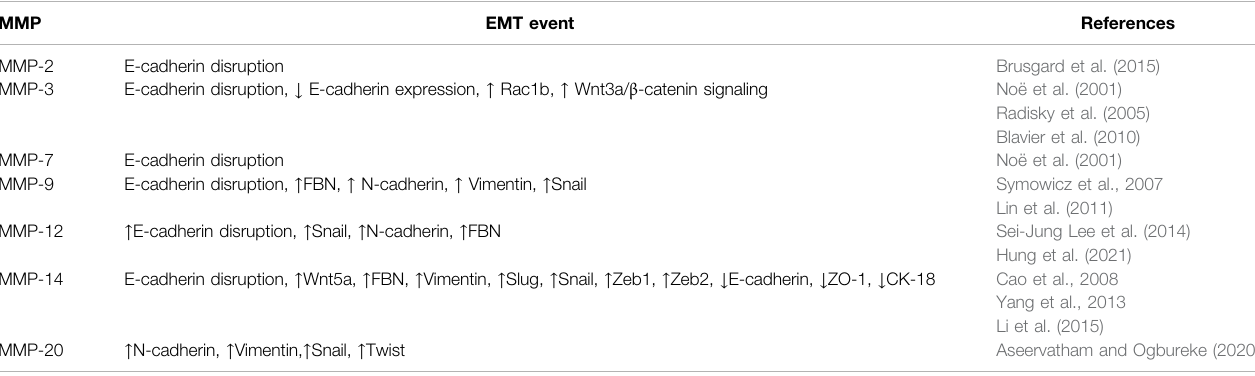
TABLE 3 | MMPs ’ effects on